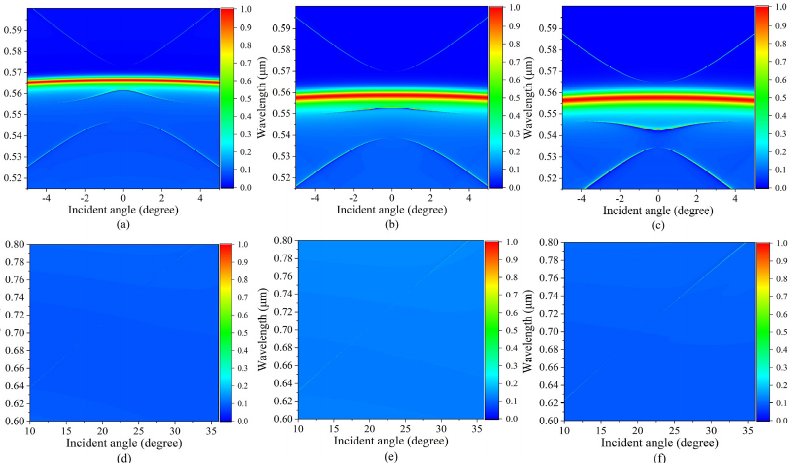
Figure 7. Reflectance spectra of the metasurface around at Γ BICs with side length ( a ) L 1 = L 2 = 0.1 µ m, ( b ) L 1 = L 2 = 0.15 µ m, and ( c ) L 1 = L 2 = 0.2 µ m, respectively, and around off Γ BIC with side length ( d ) L 1 = L 2 = 0.1 µ m, ( e ) L 1 = L 2 = 0.15 µ m, and ( f ) L 1 = L 2 = 0.2 µ m, respectively. a = 0.336 µ m, and W 1 = W 2 = 0.1 µ m.